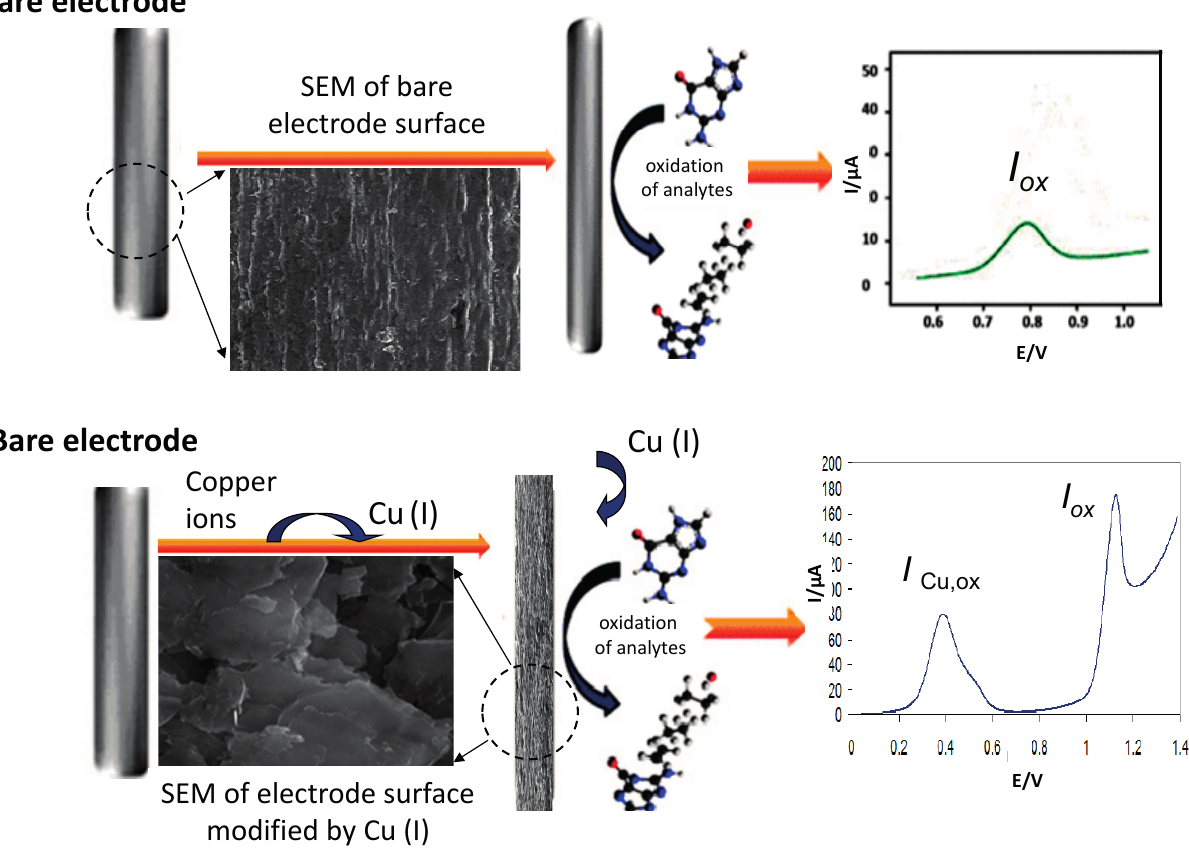
Figure 5. Voltammetric responses of oxidation processes of Cu(I)-purine complexes and their corresponding purines on pencil graphite electrodes